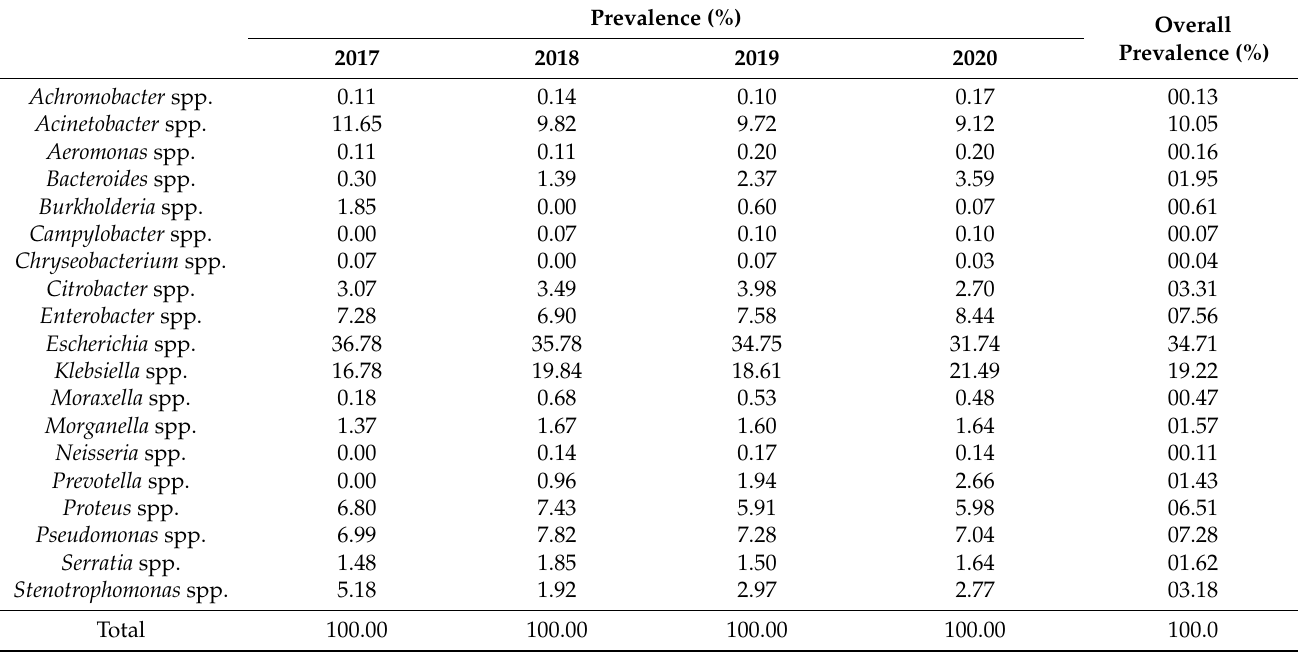
Table 1. Prevalence of different nosocomial gram-negative bacterial genus from 2017–2020. Prevalence (%)